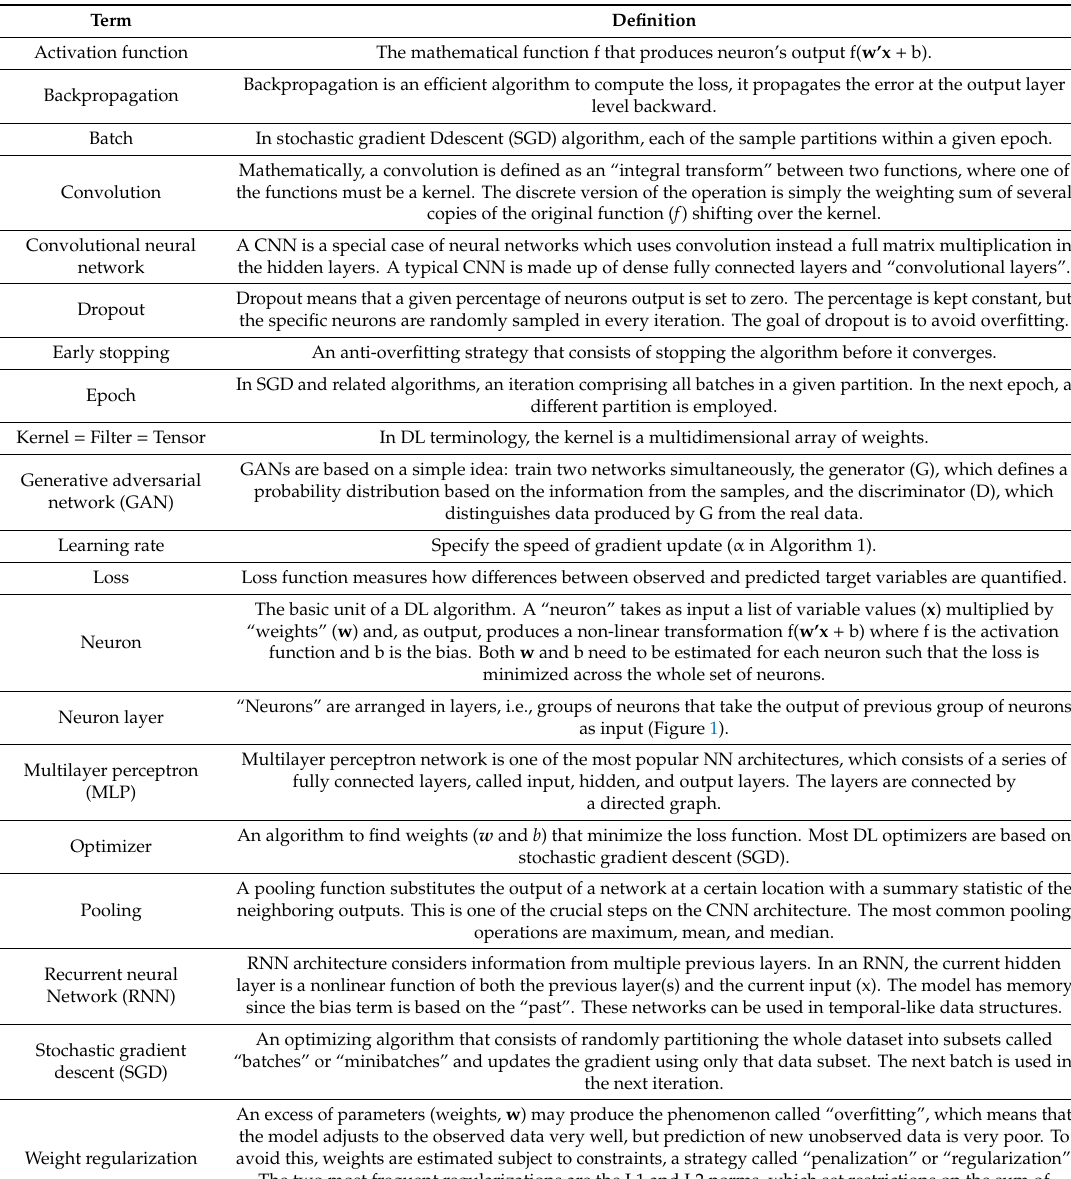
Table 1. Some usual terms in deep learning (DL)